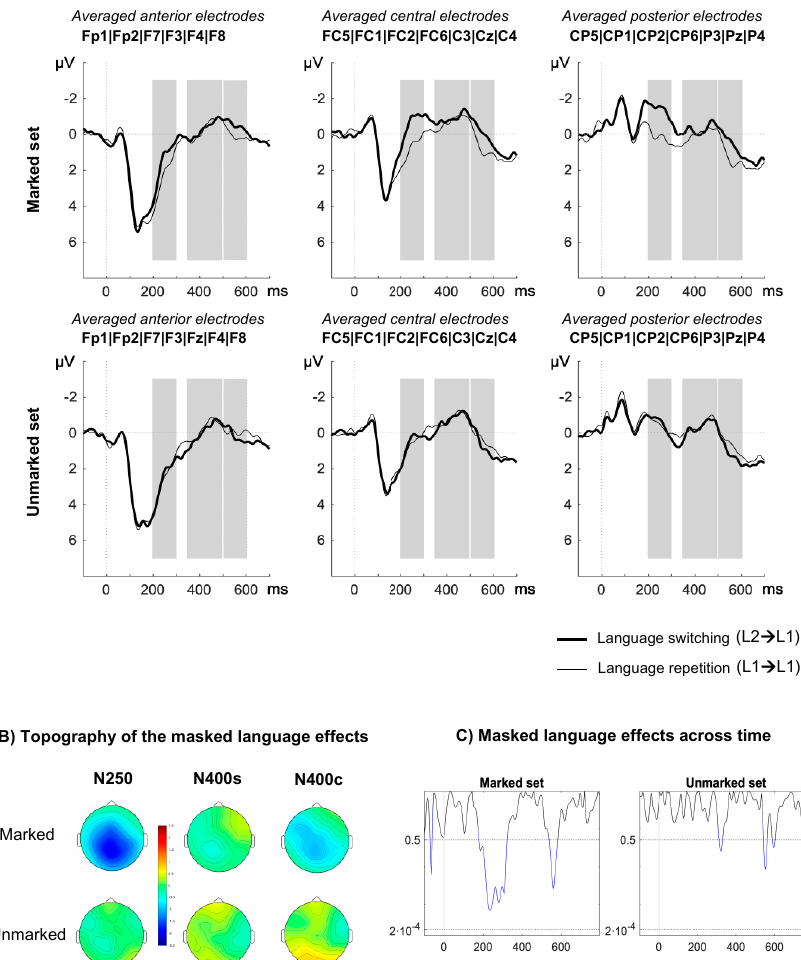
Figure 1. Event-related potential (ERP) results in Experiment 1: highly proficient Basque–Spanish bilinguals. ( A ) ERPs associated with the switch (thick lines) and non-switch conditions (thin lines) in the marked (upper) and unmarked (lower) sets. Time-windows of analysis are marked in gray. ( B ) Topographical distribution of the language switch e ff ects for marked and unmarked priming conditions in terms of amplitude di ff erences between the unrelated Basque and unrelated Spanish primes. ( C ) Time-course of p -values for the language switch e ff ect in marked and unmarked sets. The p -values are calculated from individual t -tests for every data point (every 4 ms; 225 comparisons in total) and collapsed across all electrodes. Blue lines indicate p -values > 0.05. The Bonferroni correction threshold is marked on the graph ( α = 0.05 / 255; p =